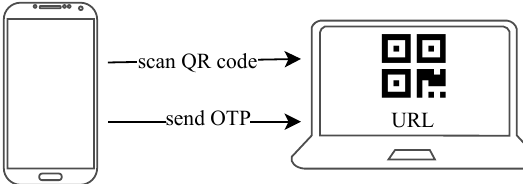
Figure 10. The mobile device scans the QR code containing a URL and sends the OTP to the